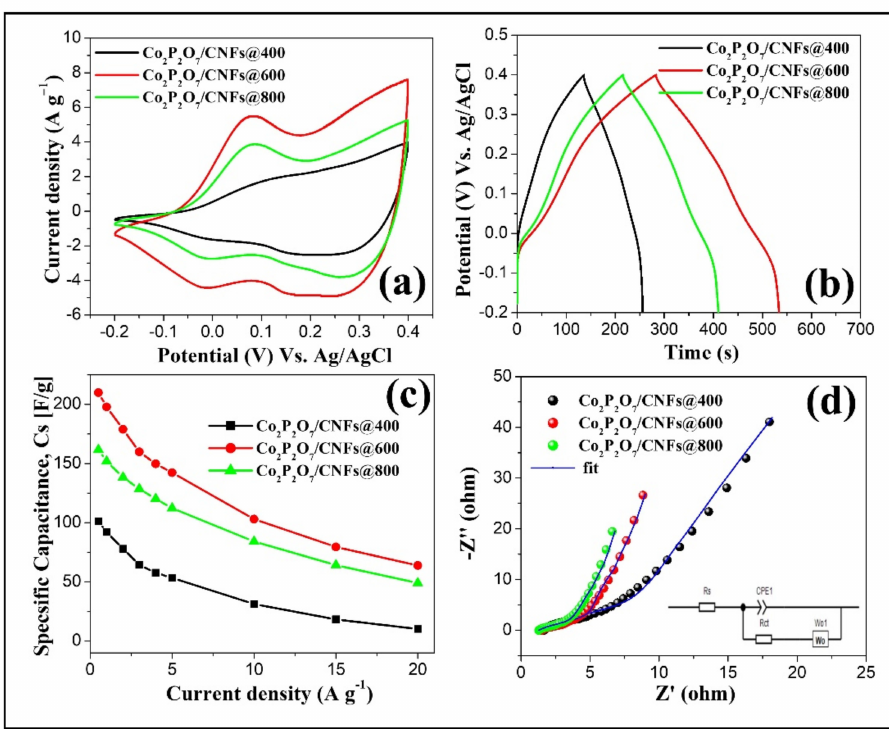
Figure 12. ( a ) CV curves at a scan rate of 20 mV s − 1 , ( b ) GCD curves at a current density of 0.5 A g − 1 , ( c ) specific area capacitance (C sa ) at various current densities, and ( d ) Nyquist plots